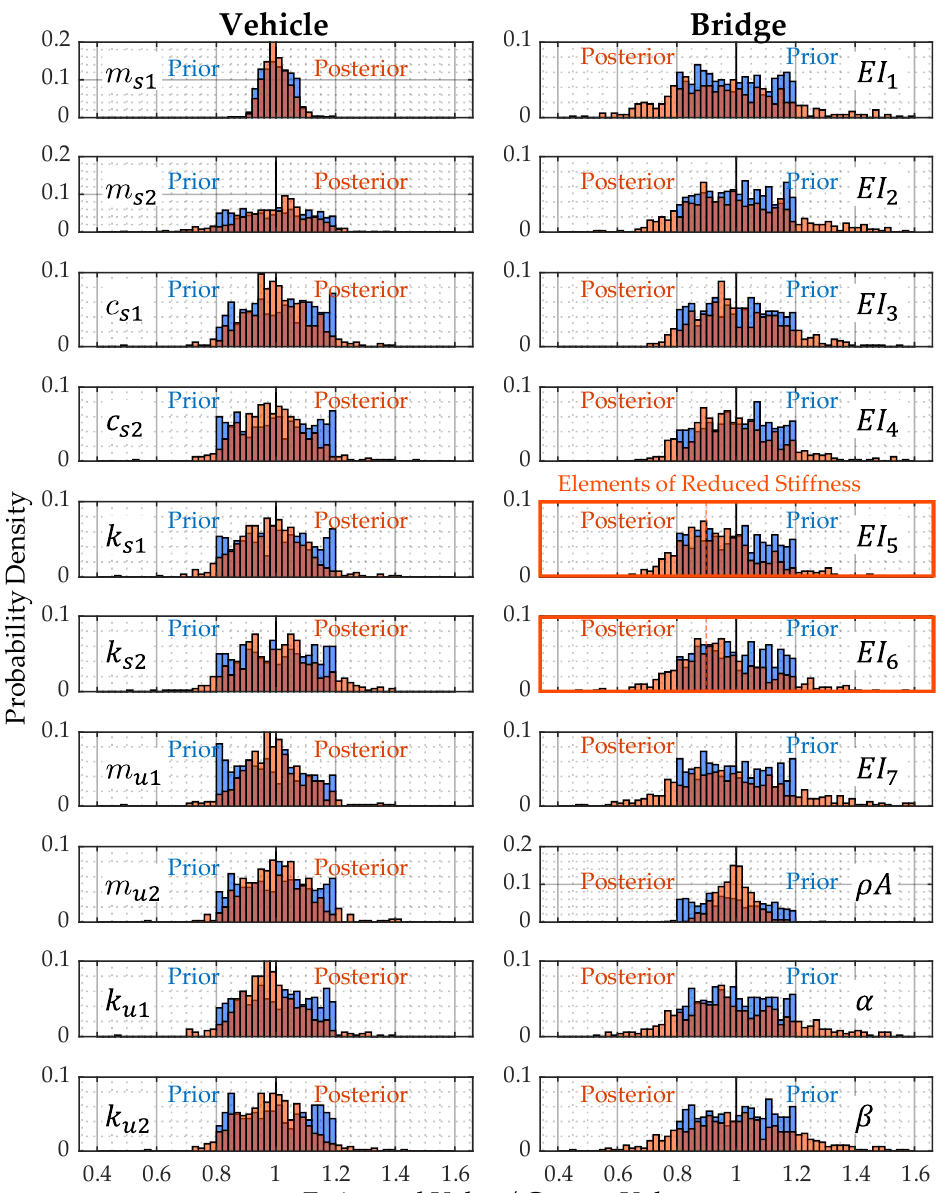
Figure A9. The application results of the PRE method in the case of Scenario 7 (stiffness decrease section: 4𝐿/7 ~ 6𝐿/7 , decrease rate: 10%).